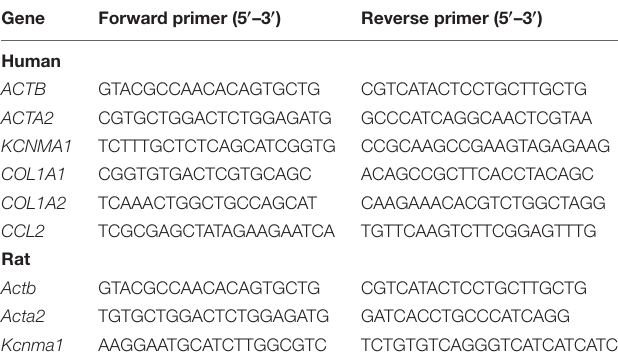
TABLE 1 | List of primers for qPCR. Gene Forward primer (5 (cid:48) –3 (cid:48) ) Reverse primer (5 (cid:48) –3 (cid:48) )